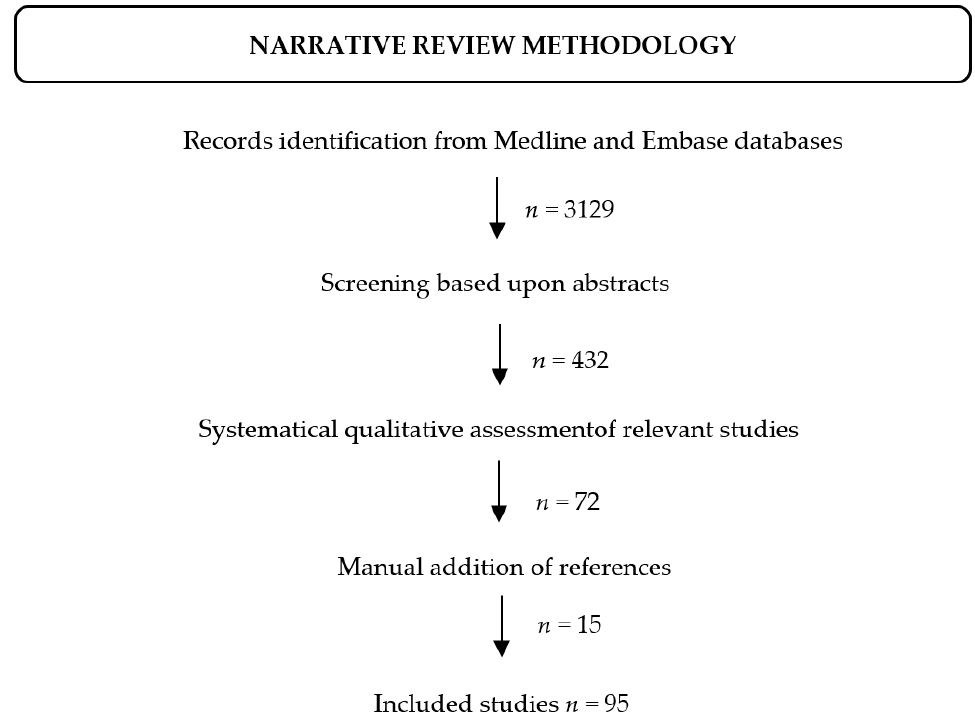
Figure 1. Flow-chart depicting the literature review process.